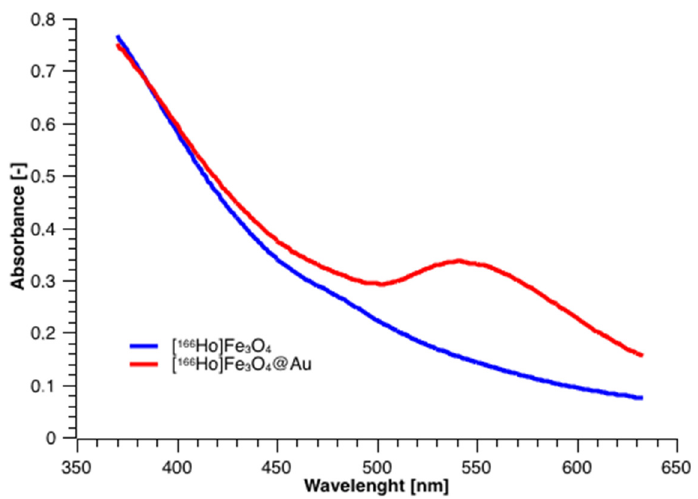
Figure 5. UV-vis spectra for [ 166 Ho]Fe 3 O 4 and [ 166 Ho]Fe 3 O 4 @Au.